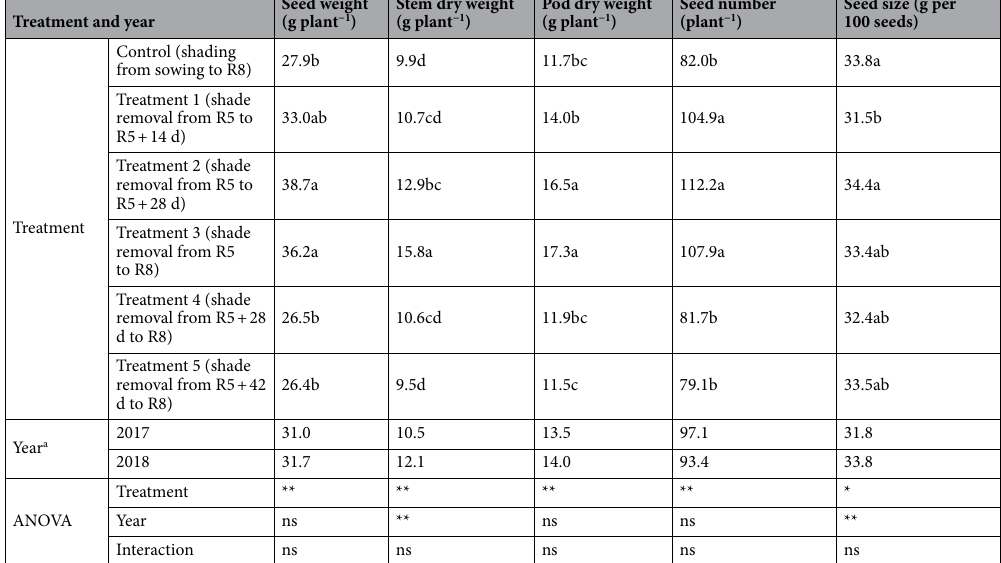
Table 3. Effects of the time and duration of shade removal on plant growth parameters. Same letters within a column indicate no significant difference (Tukey’s test, p < 0.05). **Significantly different ( p < 0.01). *Significantly different ( p < 0.05). a Average score of all treatments in each year. Statistical analyses were performed using the statistical software BellCurve for Excel version 3.21.